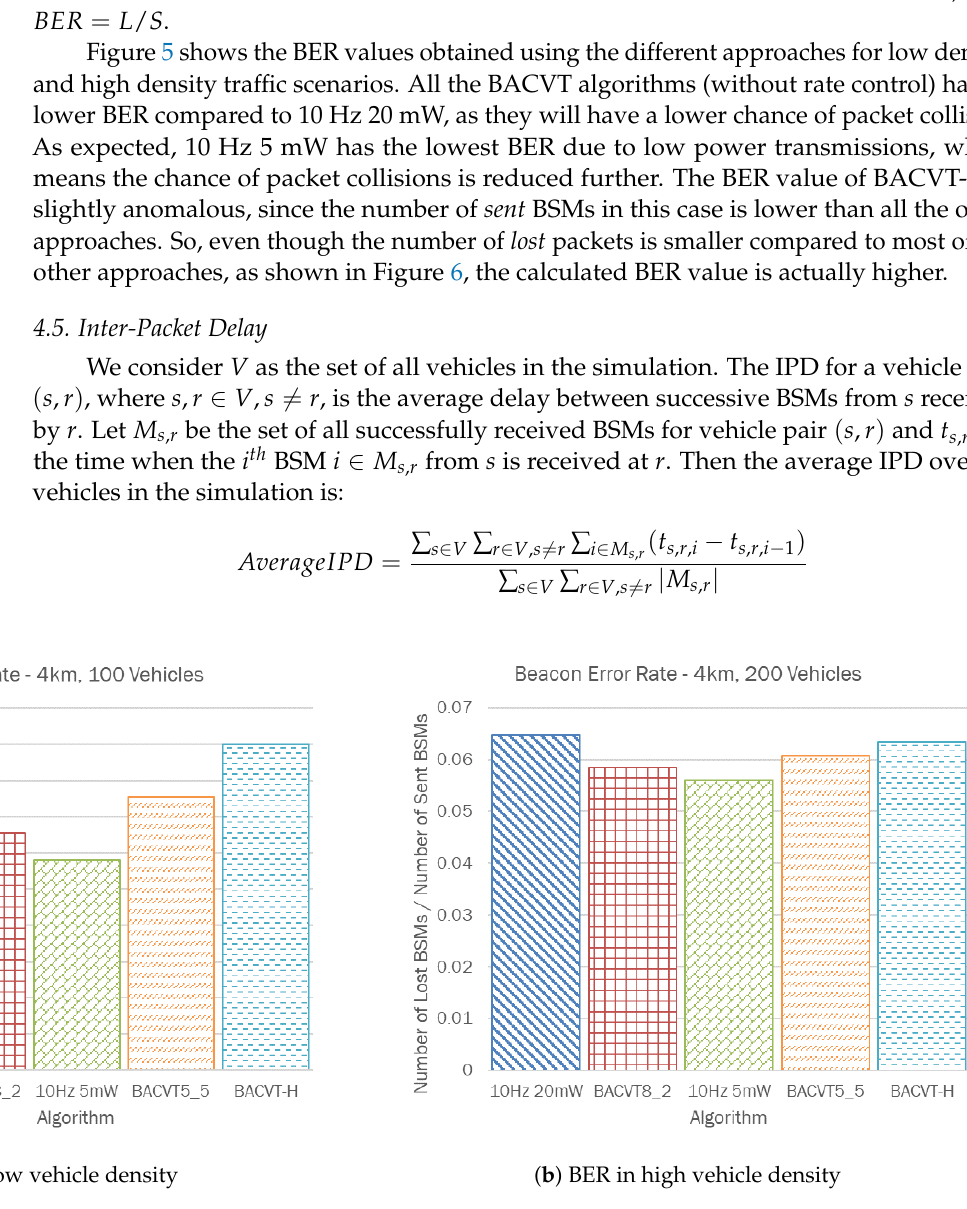
Figure 5. BER in different vehicle